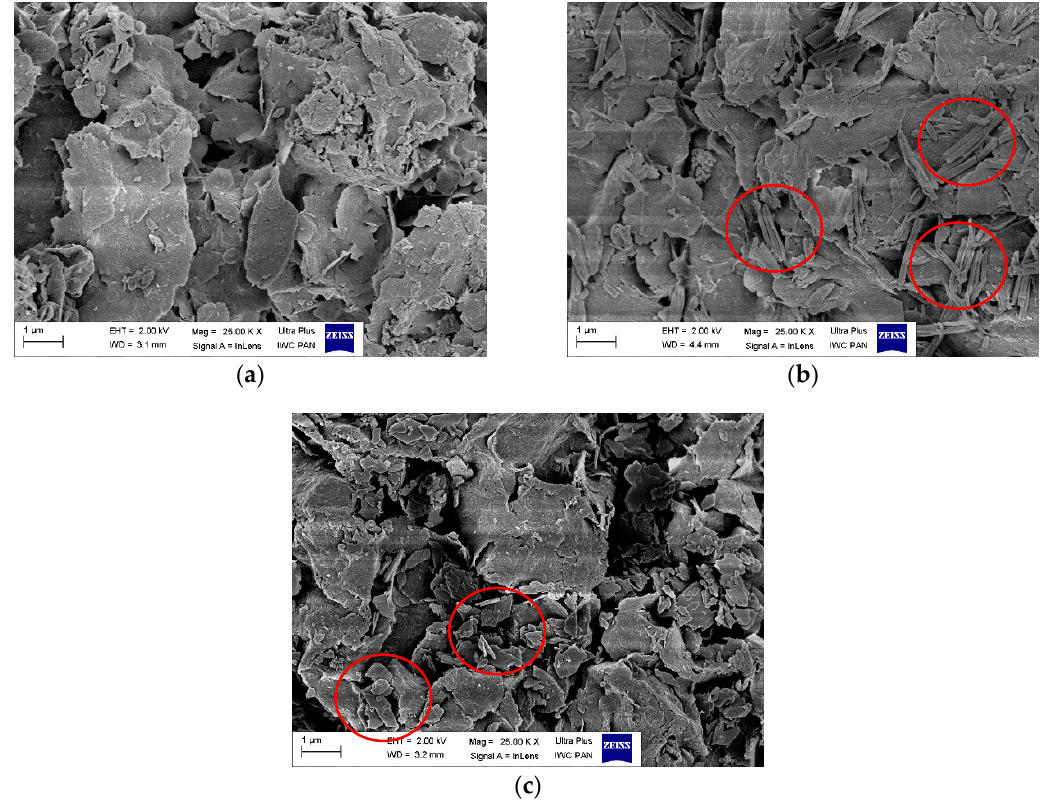
Figure 4. XRD powder diffraction patterns for (a) aluminum-magnesium hydroxycarbonate (LH), (b) HPD, (c) HPM, (d) MCD dye.